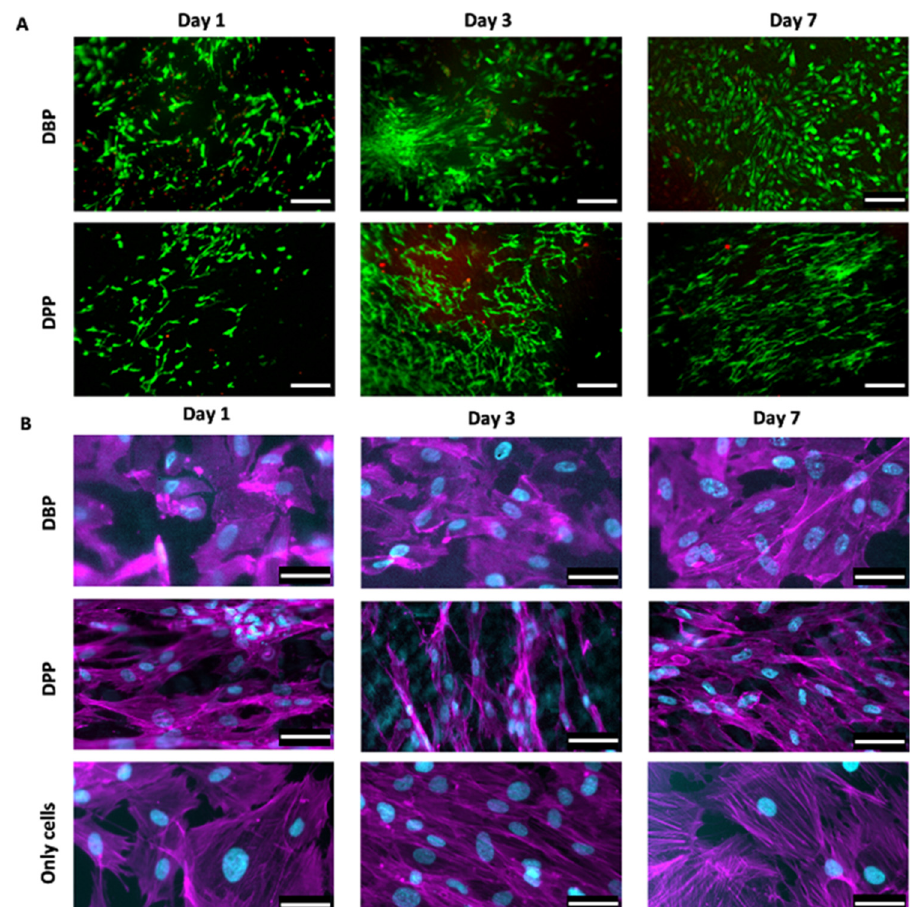
Figure 7. ( A ) Live/dead staining allows visualizing cells proliferation on the decellularized bovine and porcine pericardia (rows) at days 1, da 3, and 7 (columns): live cells were stained with Calcein AM (green), while dead cells were stained with ethidium homodimer-1 (red). Scale bar = 200 micron. ( B ) Immunofluorescence staining with fluorescent phalloidin (magenta) and DAPI (cyan) showed cells seeded on the decellularized bovine and porcine pericardia (rows) at days 1, 3, and 7 (columns); the third row represents cells over the control surface (plastic). Scale bar = 50 micron.